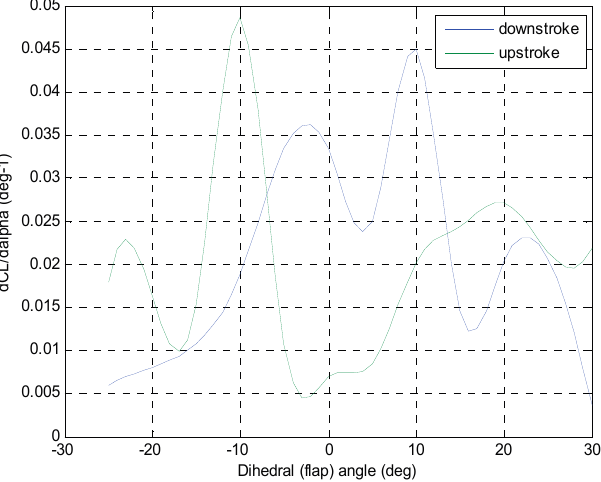
Figure 11. The lift coefficients derivatives with respect to flapping angle (d C L /d α ), from C L